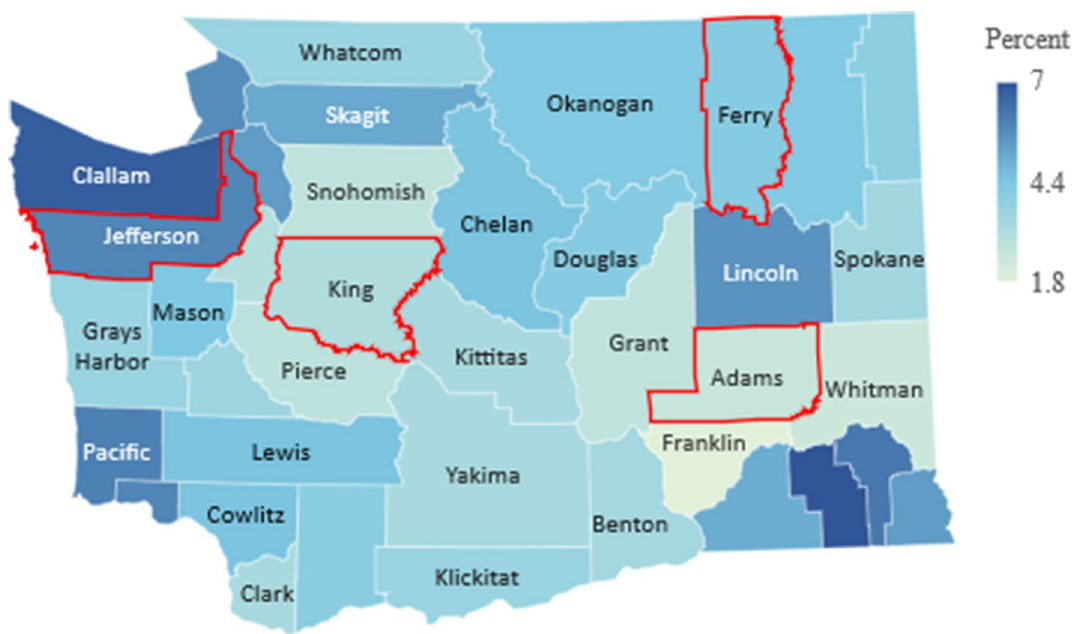
Figure 6. Percent of population over 80. Figure made with Excel using dataset in 9